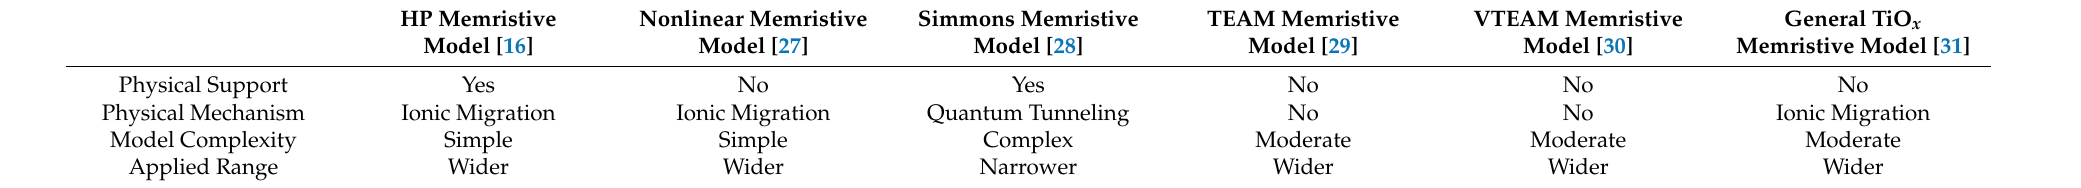
Table 2. Comparative information of different memristive